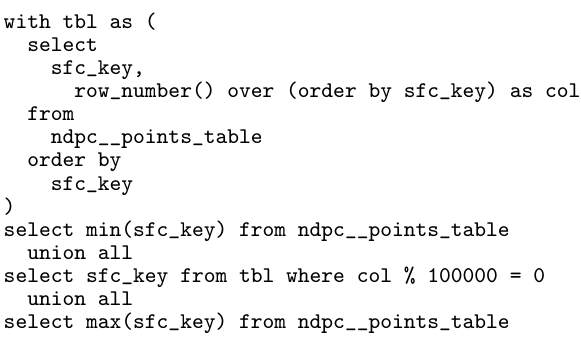
Figure 8. Query for determing sfc key bounds, leading to blocks with exactly 100 000 points (except last block which might be underfull). The blocks may overlap each other